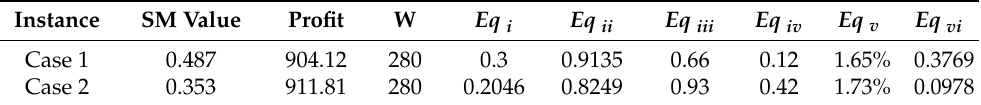
Table 8. Simulation